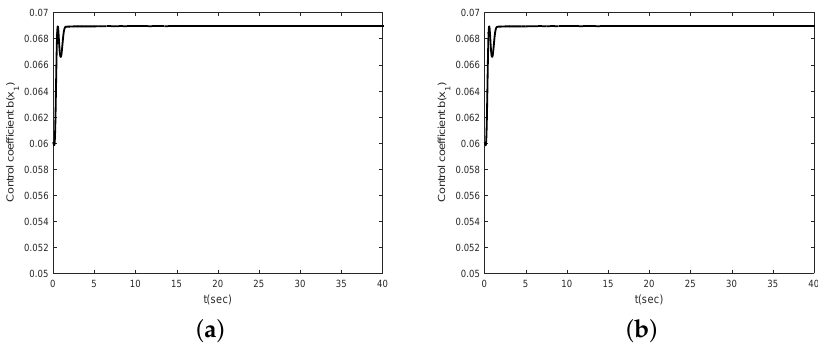
Figure 4. Control coefficient b ( x 1 ) : ( a ) θ ( 0 ) = 20 ◦ ; ( b ) θ ( 0 ) = − 20 ◦ .